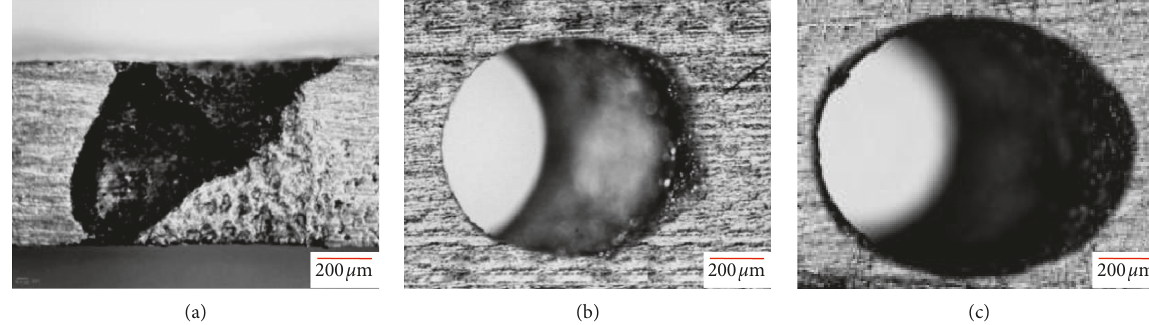
Figure 6: Cooling hole samples machined under different applied voltages. (a) U � 5V, ξ � 5% (wt.%). (b) U � 9V, ξ � 5% (wt.%). (c) U � 13V, ξ � 5%